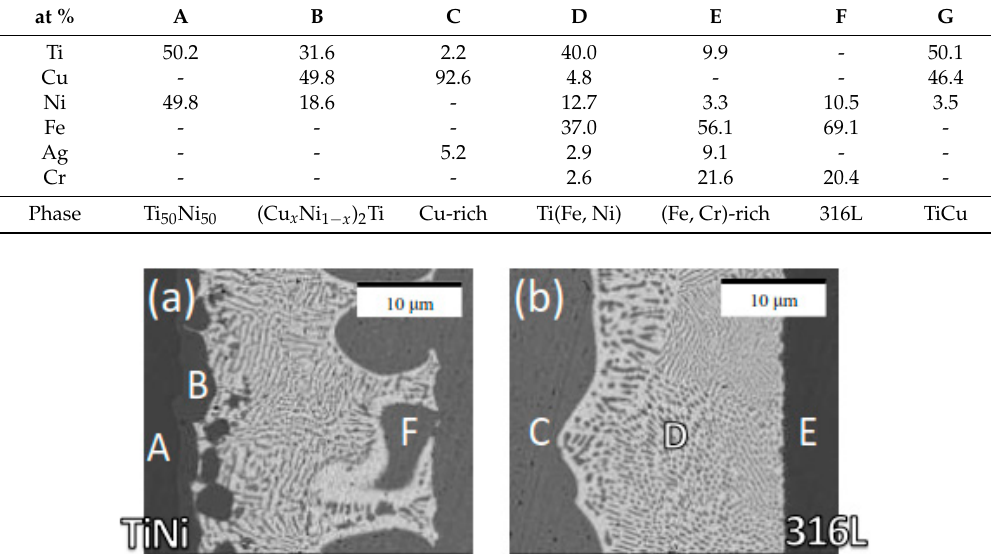
Figure 6. SEM BEI cross sections of Ti 50 Ni 50 /Cusil-ABA/50 μ m Cu foil/BAg-8/316L SS specimen infrared brazed at 850 °C for 300 s: ( a ) the Ti 50 Ni 50 substrate side; ( b ) the 316L SS substrate side. (TiNi: Ti 50 Ni 50 substrate, 316L: 316L SS substrate). Table 4. EDS chemical analysis results in Figure 6. Table 4. EDS chemical analysis results in Figure 6. Table 4. EDS chemical analysis results in Figure